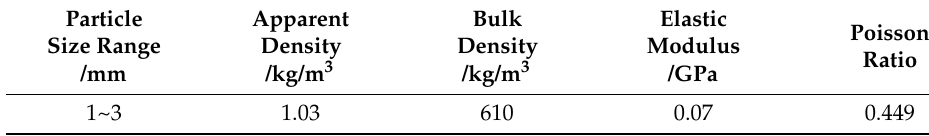
Table 3. Basic performance indicators of rubber particles.